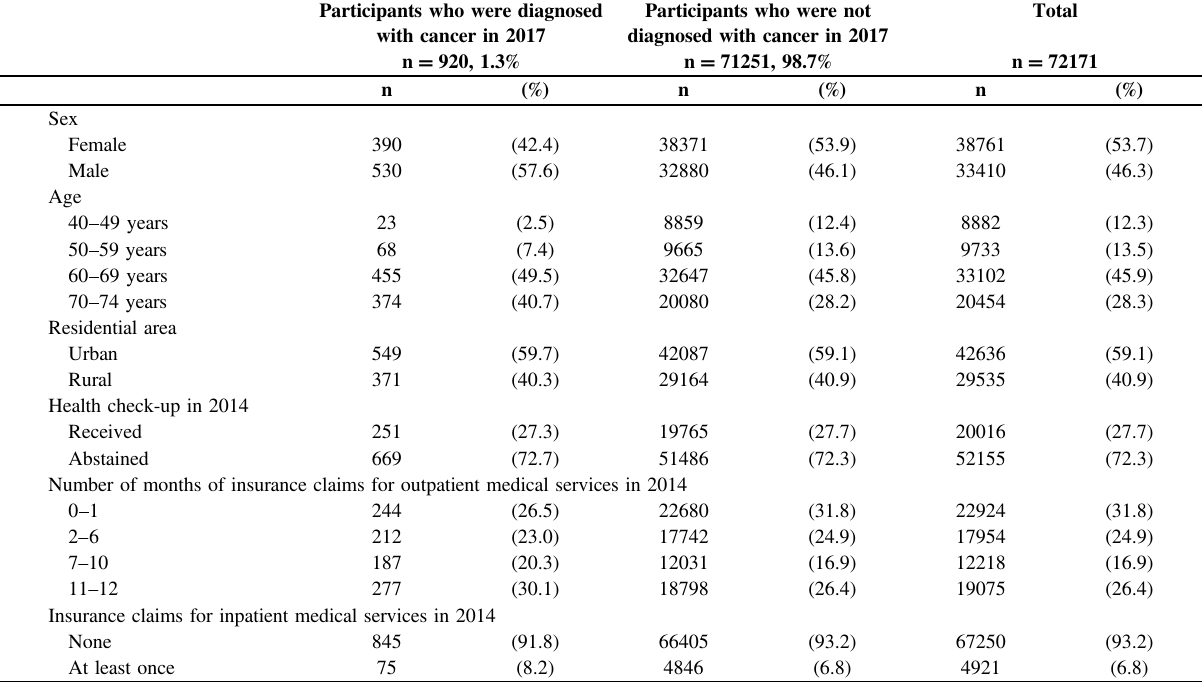
Table 1 Baseline data of study participants